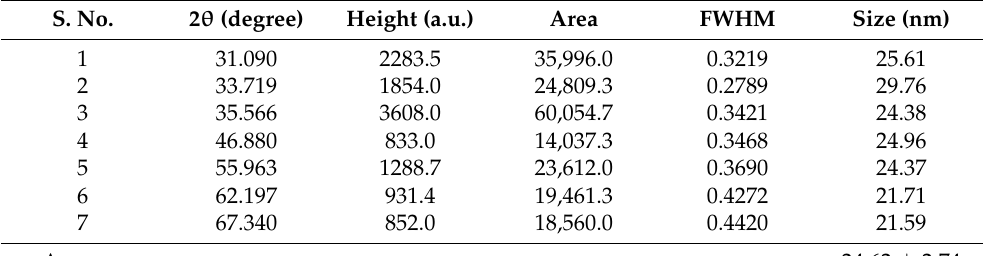
Figure 1. ( A ) UV–visible absorption spectrum of ZnO-NPs synthesized using P. zeylanica extract. ( B ) X-ray diffraction pattern of ZnO-NPs. Table 1. Details of the most intense peaks of ZnO-NPs synthesized using P. zeylanica extract obtained from X-ray diffraction.